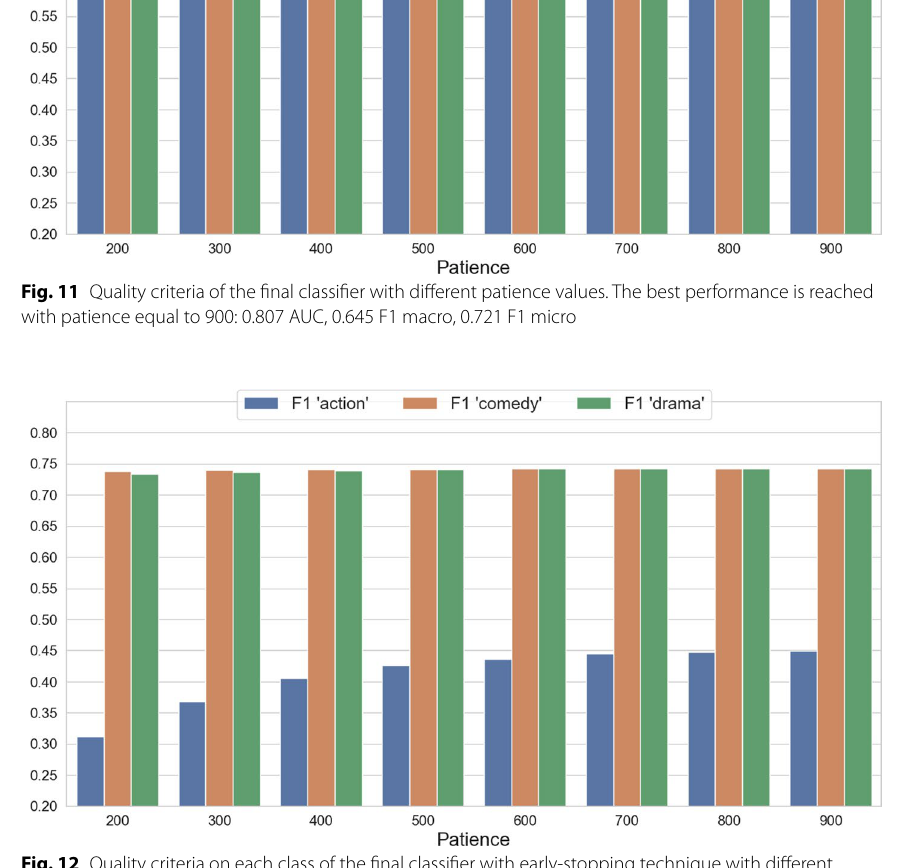
Fig. 12 Quality criteria on each class of the final classifier with early-stopping technique with different patience